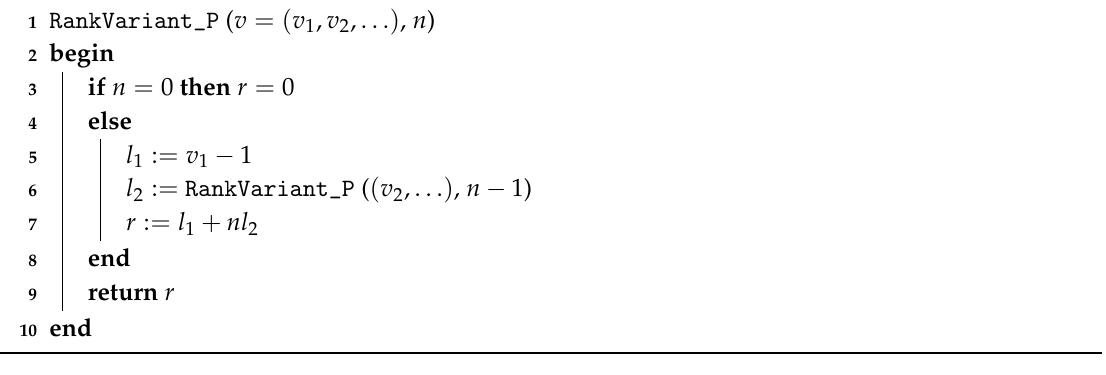
Algorithm 9: An algorithm for ranking the variants of the AND/OR tree for P n .